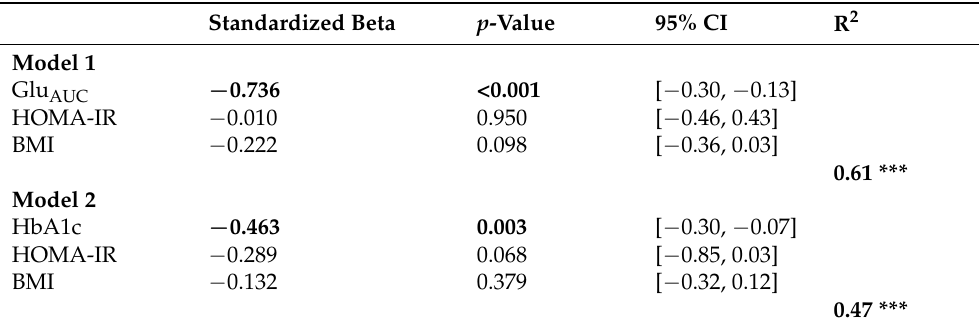
Table 2. Multiple linear regression models of principal component score 1 (PC1) derived from metabolites with significantly different fold changes after the OGTT between T2D and control subjects vs. insulin sensitivity and